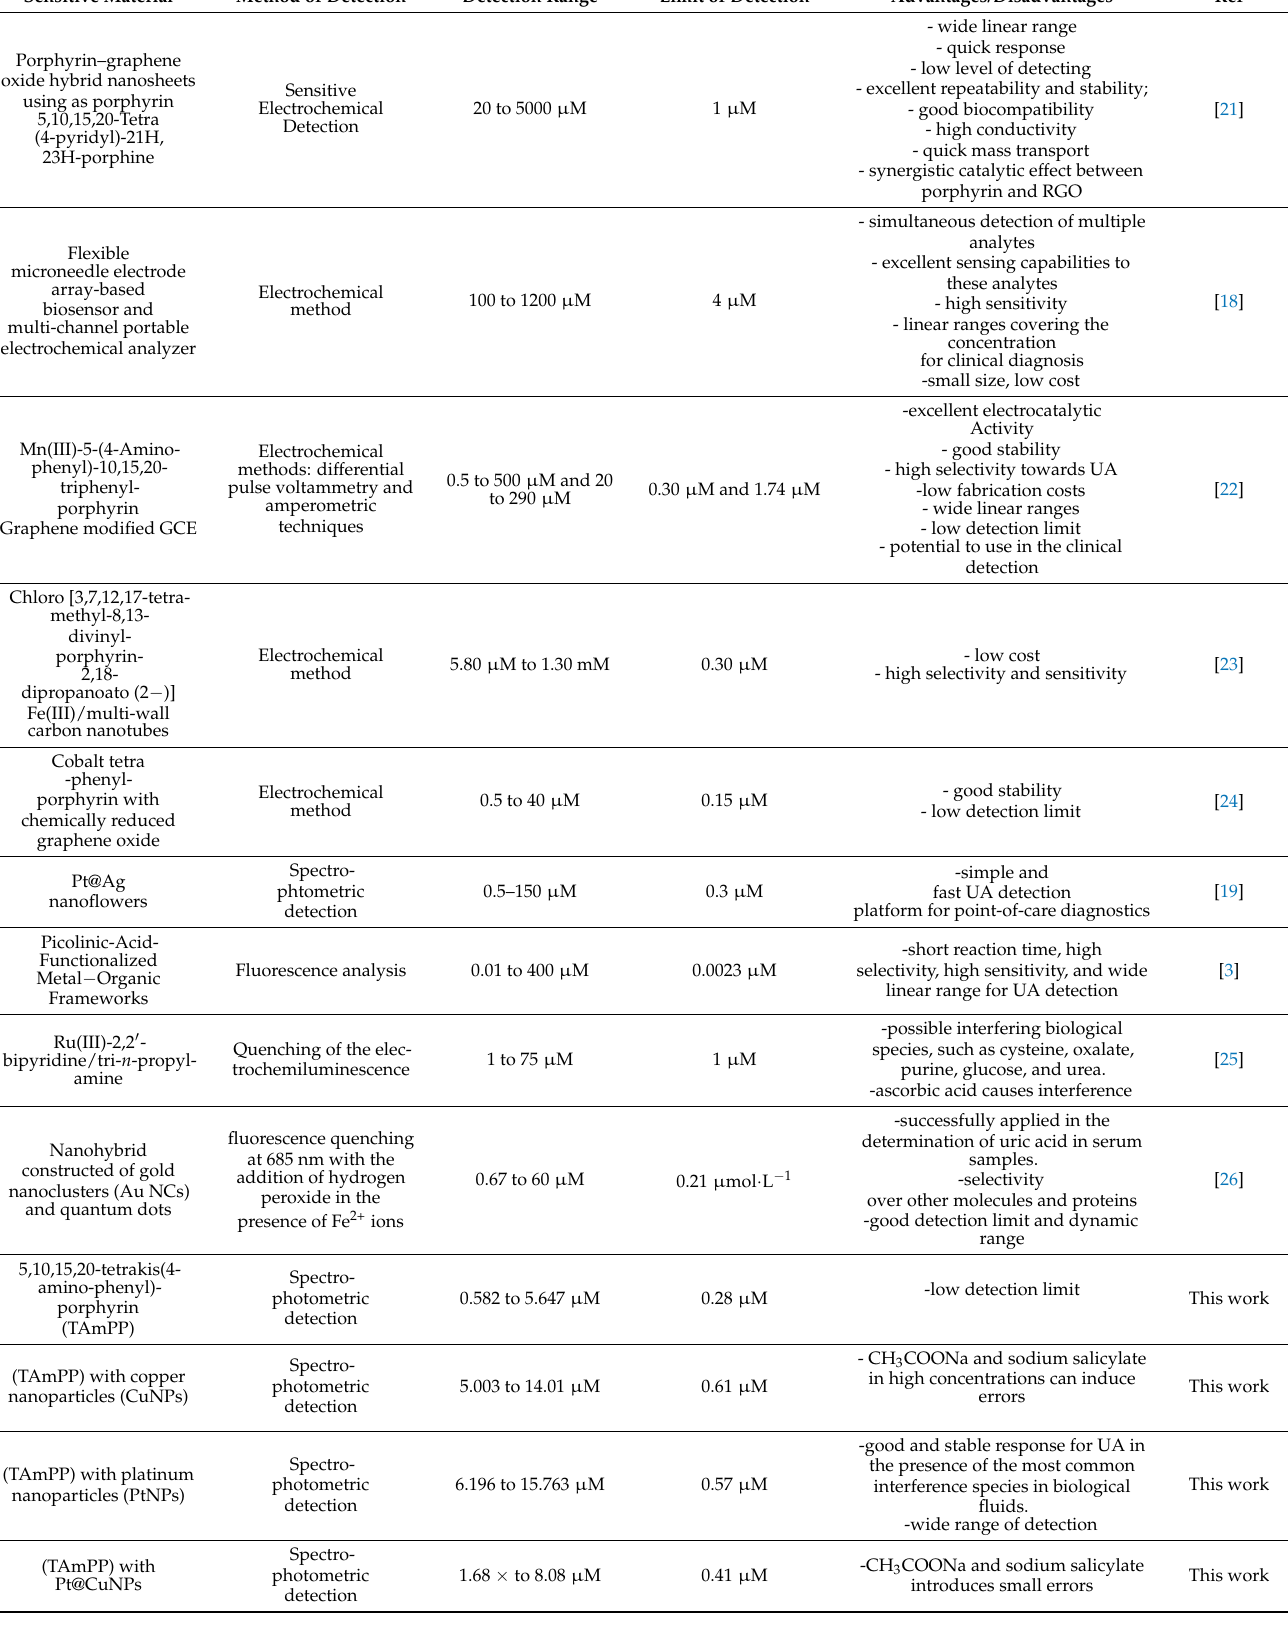
Table 1. Recently developed detection methods of uric acid. Sensitive materials, concentration ranges, and detection